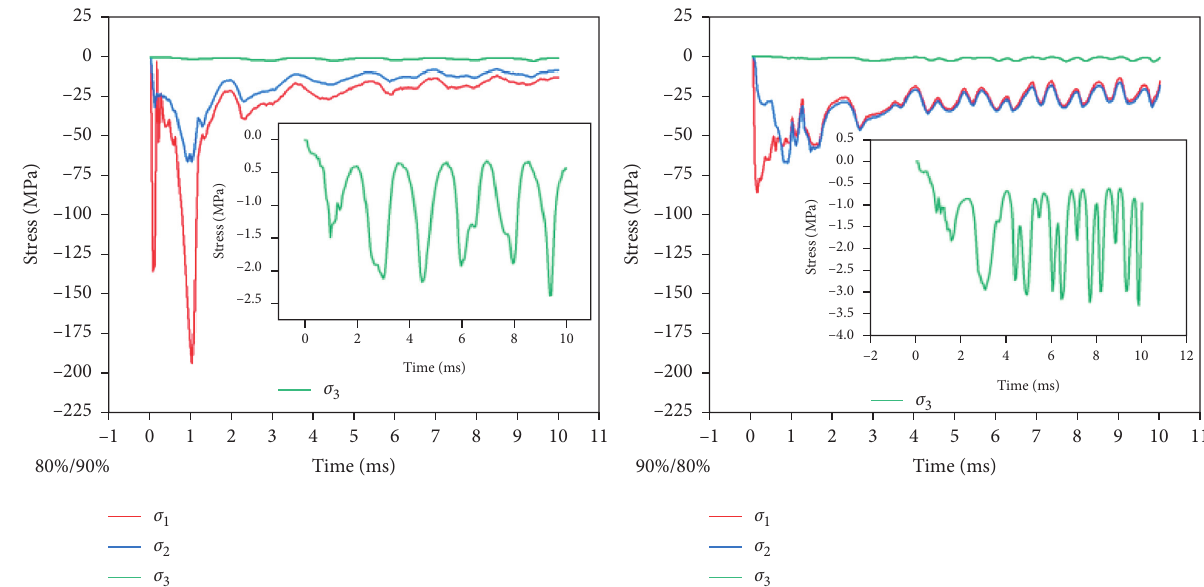
Figure 13: Double-layer aluminum foam with porosity of 80% and